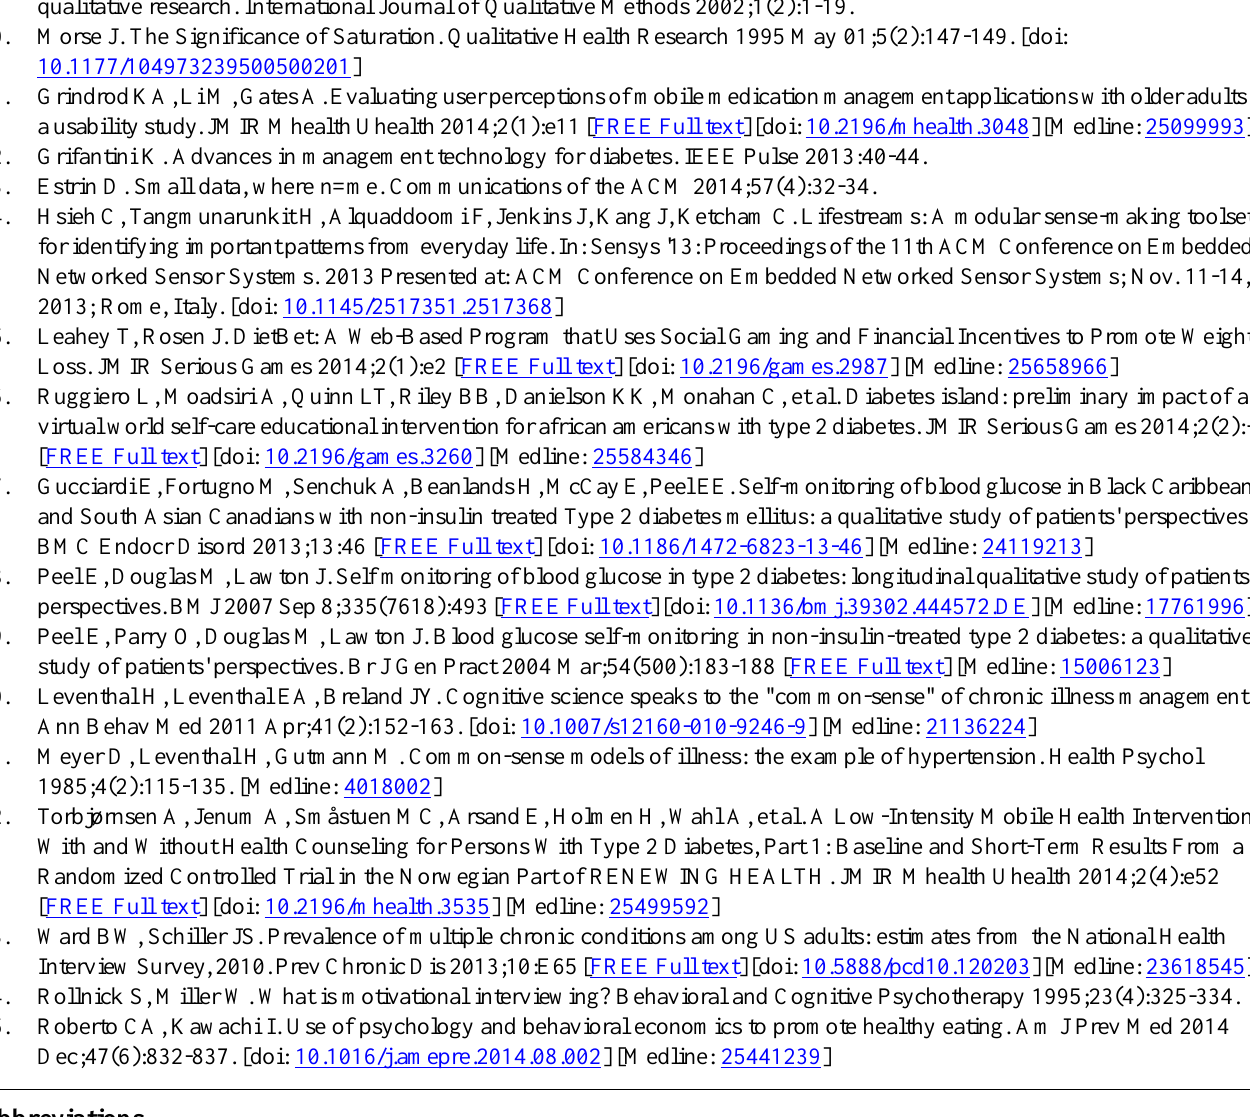
Abbreviations HIT: health information technology HIV: human immunodeficiency virus MCC: multiple chronic